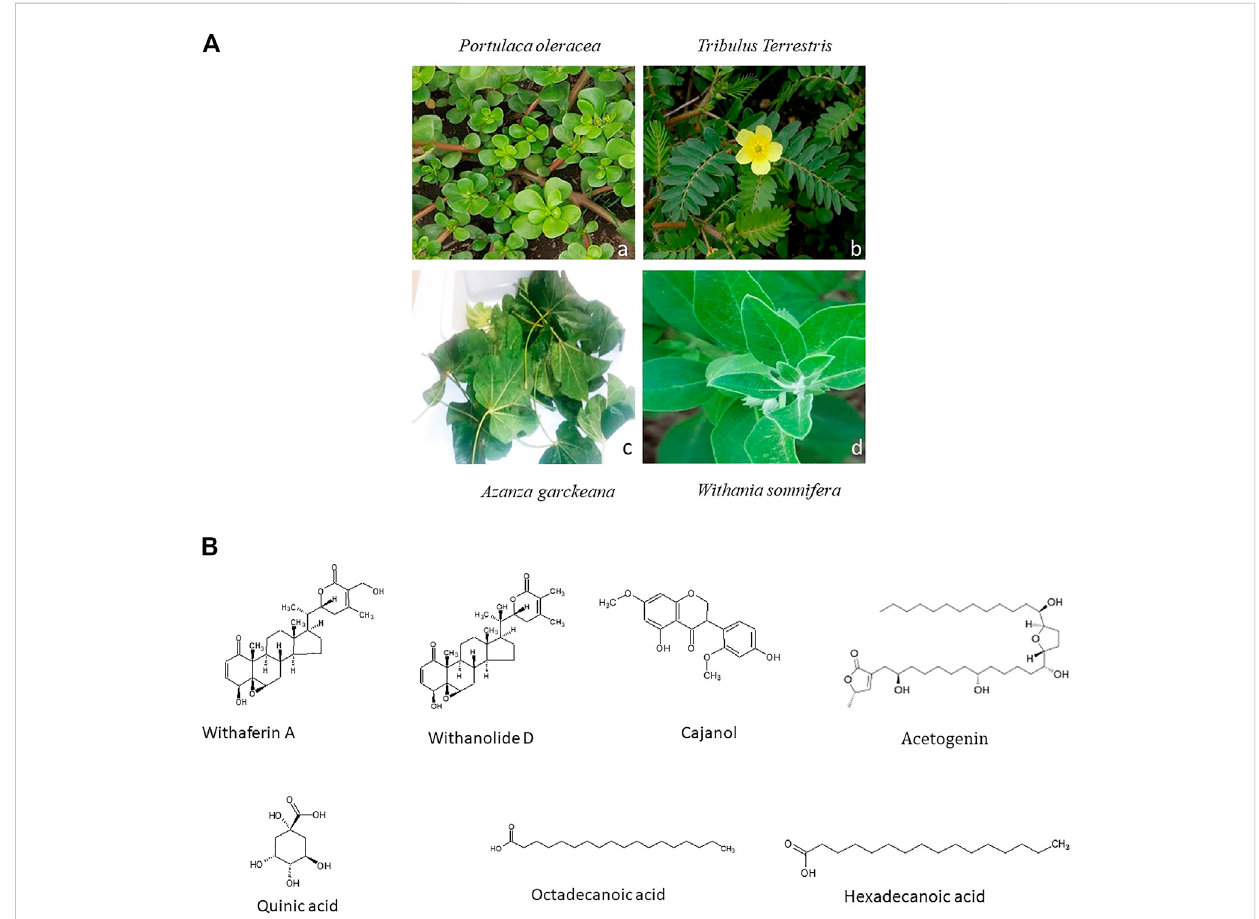
FIGURE 1 (A) Imagesofaselected AfricanMedicinal Plants speciesusedforCancermanagement. Leavesof Portulacaoleracea are fl eshy andoval (a) (Source: https://www.terrepromise.ca/en/products/lettuce/greens/[accessed12Oct2022]), TribulusTerrestris leavesareoppositeeachotherandunequalinsize (b) (Source: https://www.zimbabwe fl ora.co.zw/speciesdata/image-display.php?species_id=132940&image_id=4 [accessed 3 Nov 2022]) , Harvested leaves of Azanza garckeana showing a linear midrib fi ssure (c) , Withania somnifera leaves are broadly ovate with curvy margins (d) (Source: https:// www.magicgardenseeds.co.uk/The-Good-To-Know/Winter-Cherry-(Withania-somnifera)-A.WIT01- [accessed 27 October 2022]). (B) Structures of some Phytochemicals derived from African Medicinal